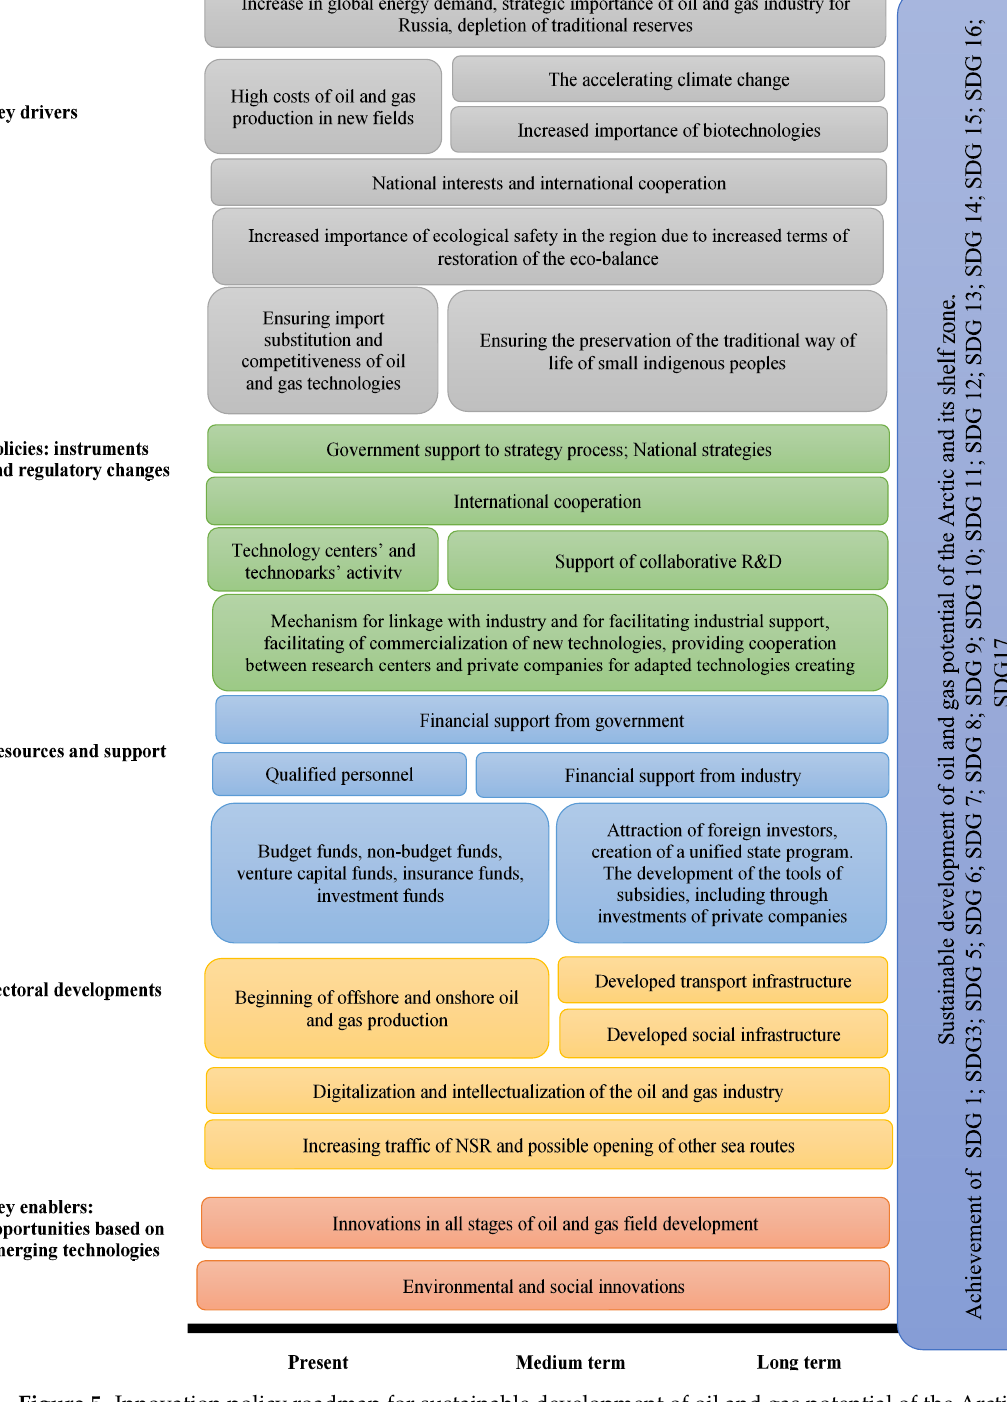
Figure 5. Innovation policy roadmap for sustainable development of oil and gas potential of the Arctic and its shelf zone.